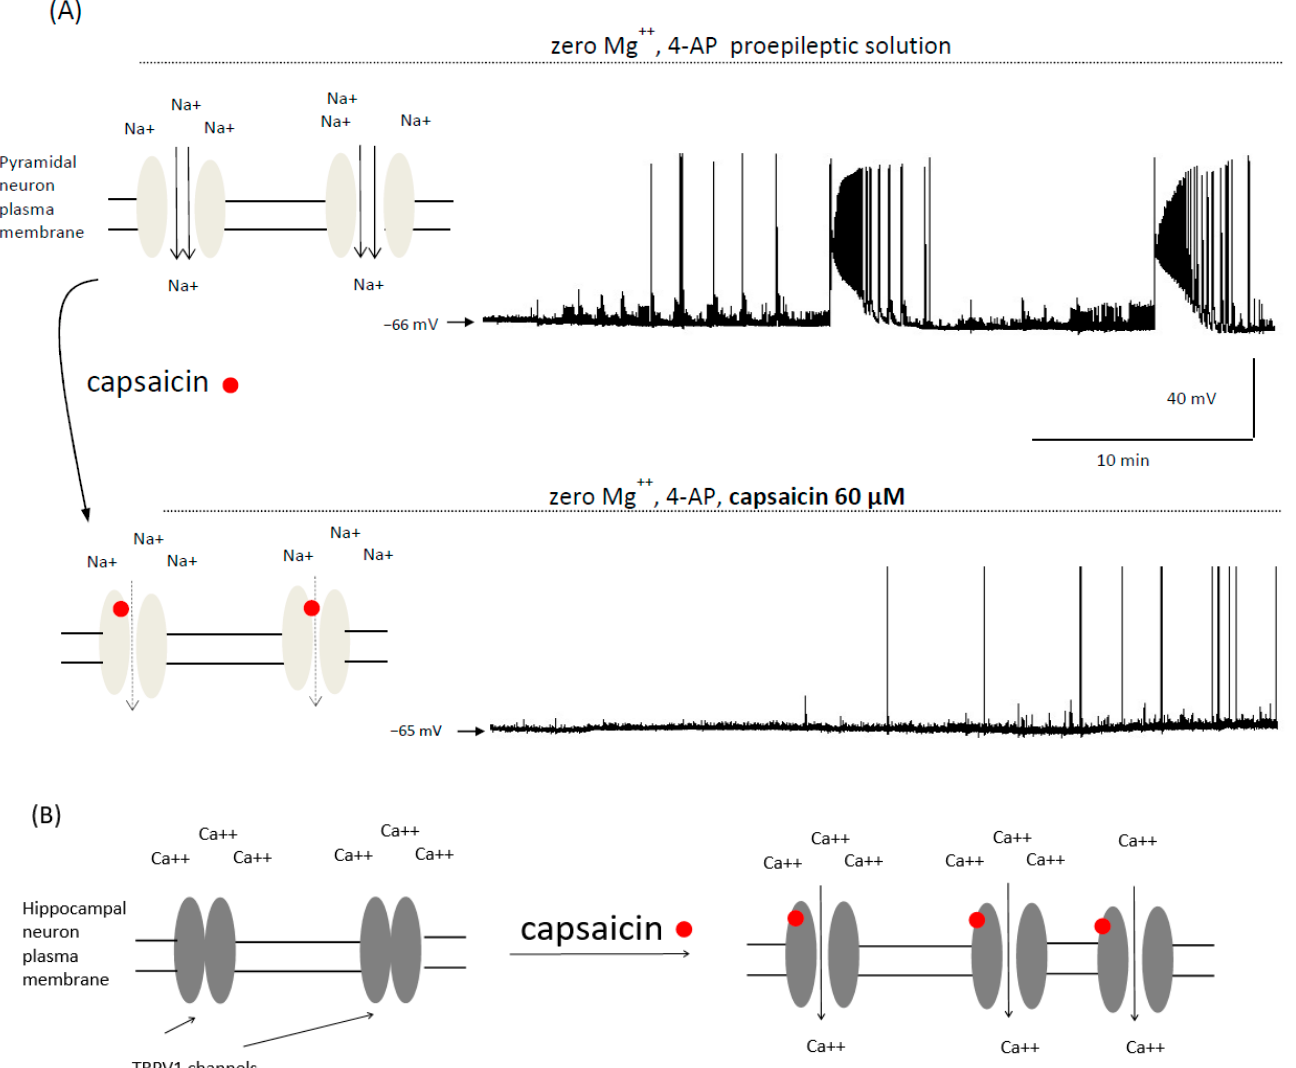
Figure 4. Animal studies show that capsaicin exerts both anti- and proepileptic effects. ( A )—the top panel shows a schematic drawing of voltage-gated sodium channels in the plasma membrane of a brain cortical neuron. Example epileptic events recorded from a cortical neuron in vitro are also shown. A patch-clamp recording was made in proepileptic extracellular solution containing zero magnesium and potassium channels inhibitor 4-AP. The bottom panel shows that capsaicin potently inhibits epileptic activity [3]. The blockading of sodium channels by capsaicin removes depolarization and contributes to the antiepileptic effect of capsaicin. Please note that a number of other channels contribute to the generation of epileptic seizures such as calcium channels which may also be blocked by capsaicin. The recordings shown in Figure 4A were presented in our